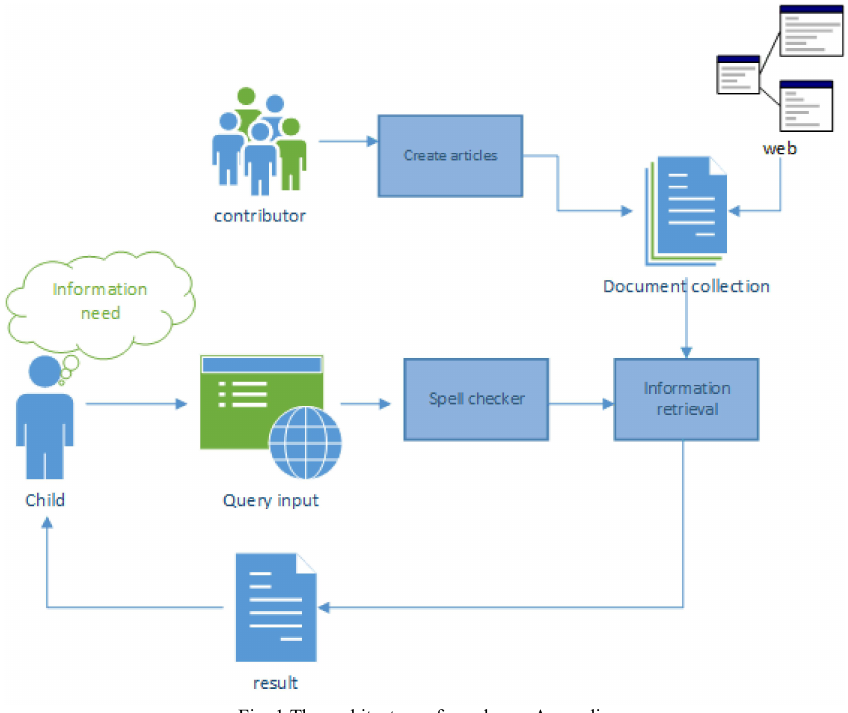
Fig. 1 The architecture of a web app